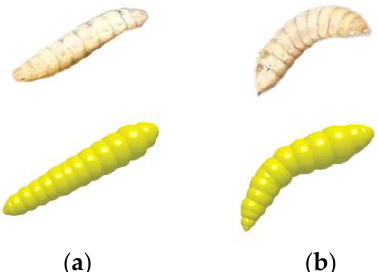
Figure 6. Simulation model of black soldier fly larvae. ( a ) Straight BSFL. ( b ) Curled BSFL.